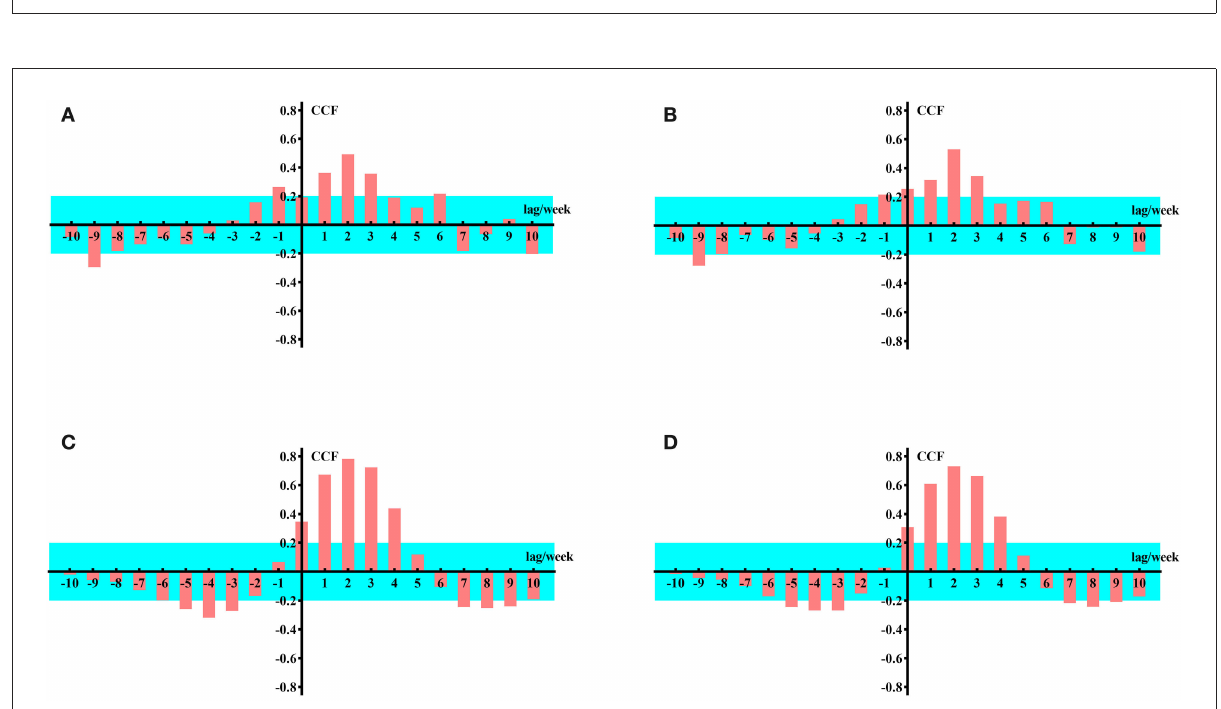
FIGURE3 Cross-correlation function values for global data. (A) Google Trends data for loss of smell worldwide as the input sequence. (B) Google Trends data for loss of taste worldwide as the input sequence.